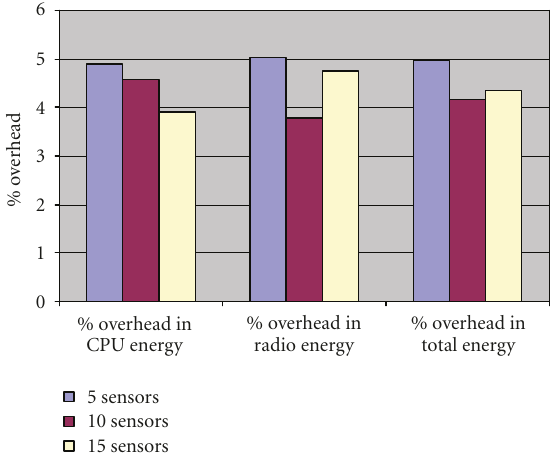
Figure 11: Percentage energy overhead using SKEA—Symmetric session key establishment (with and without HMAC authentica-